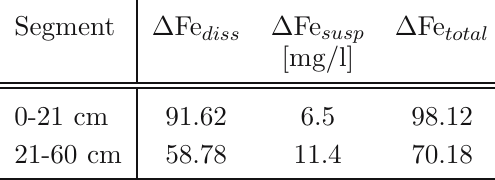
Fig. 10 SEM image of the suspended fraction in back-scattered electron (BSE) mode. Secondary siderite at the right (point 3.1) is covered by ferric hydroxides (at the left) formed during sampling. Determination of minerals is based on EDX analyses and mass balance calculations. Table 6 Total amount of Fe produced in cell including suspended